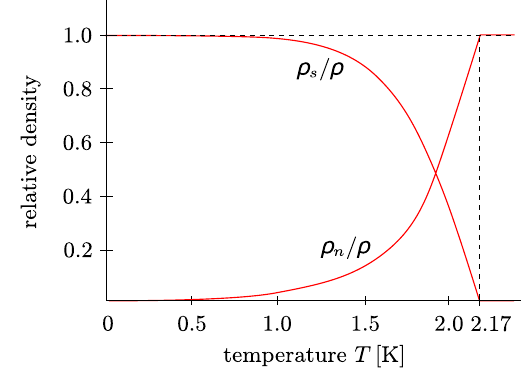
FIG. 2. Relative density versus temperature below the (cid:1) point in helium.